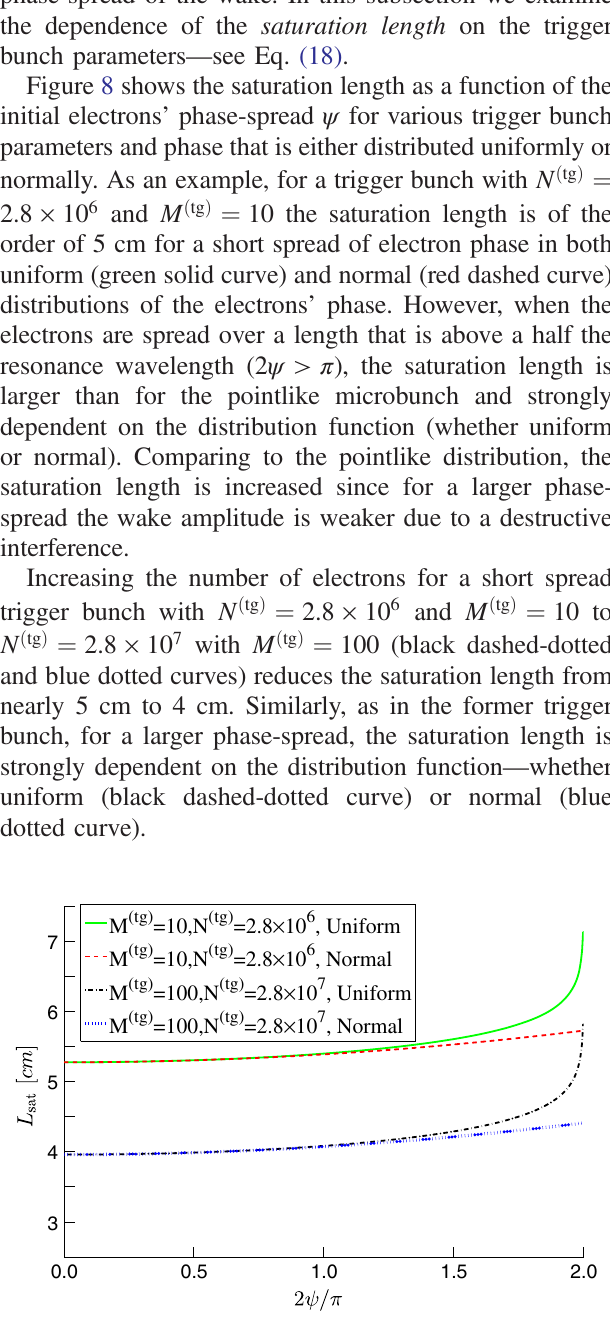
FIG. 8. The dependence of the saturation length [Eq. (18)] on the number of electrons in each microbunch N ð tg Þ , the number of microbunches M ð tg Þ , and the initial phase-spread of each microbunch 2 ψ = π .